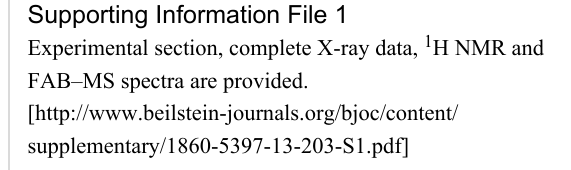
3.45 Å, 149°; 2.56, 3.26 Å, 130°). The hydroxy groups of